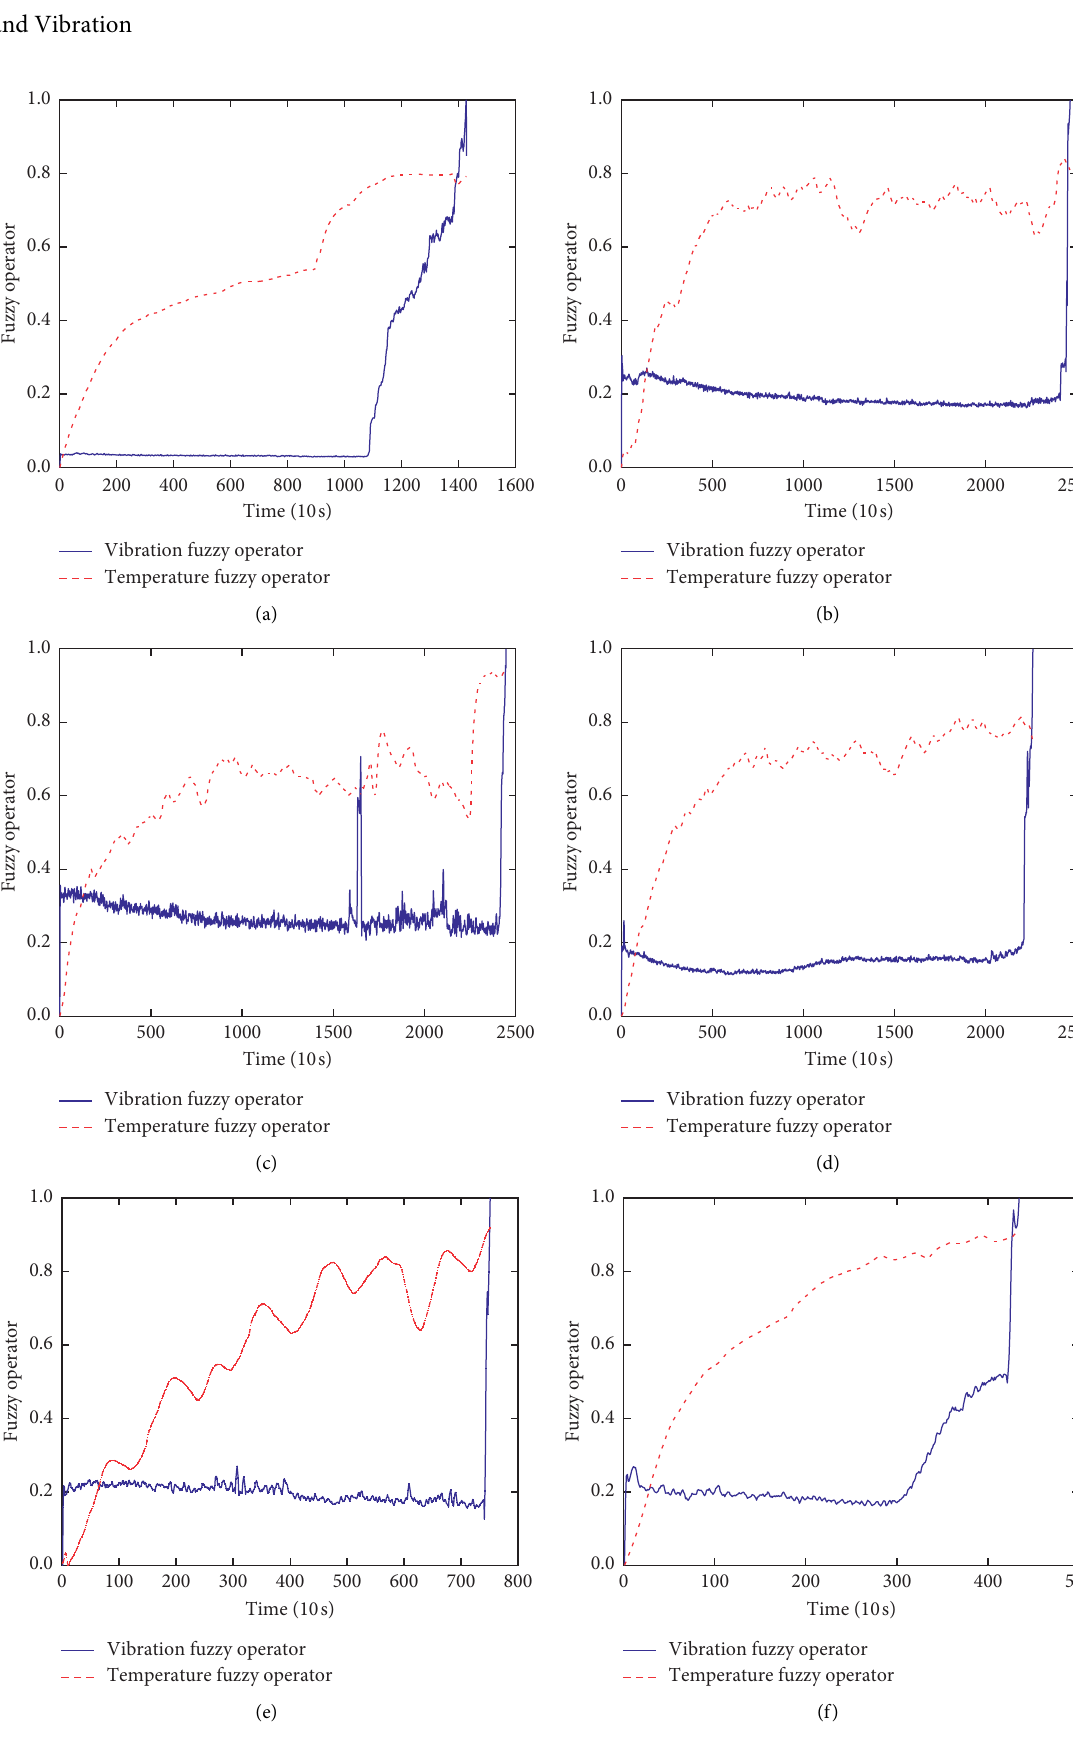
Figure 6: Vibration and temperature fuzzy operator for 6 bearings from different operation conditions. (a) Bearing 1-4. (b) Bearing 1-5. (c) Bearing 1-6. (d) Bearing 1-7. (e) Bearing 2-4. (f) Bearing